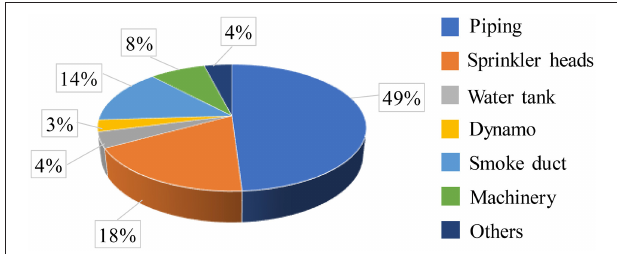
FIGURE 3 | Component loss of fire sprinkler system in the Tohoku